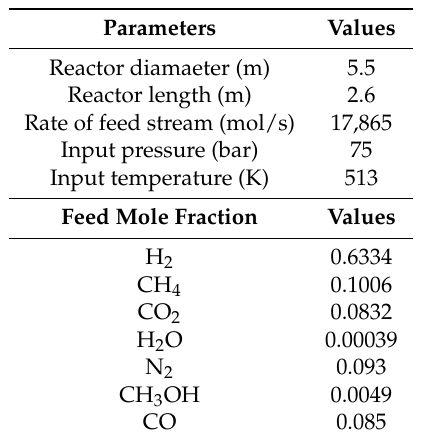
Table 6. The operating conditions and specification of adiabatic reactor of ACW configuration.